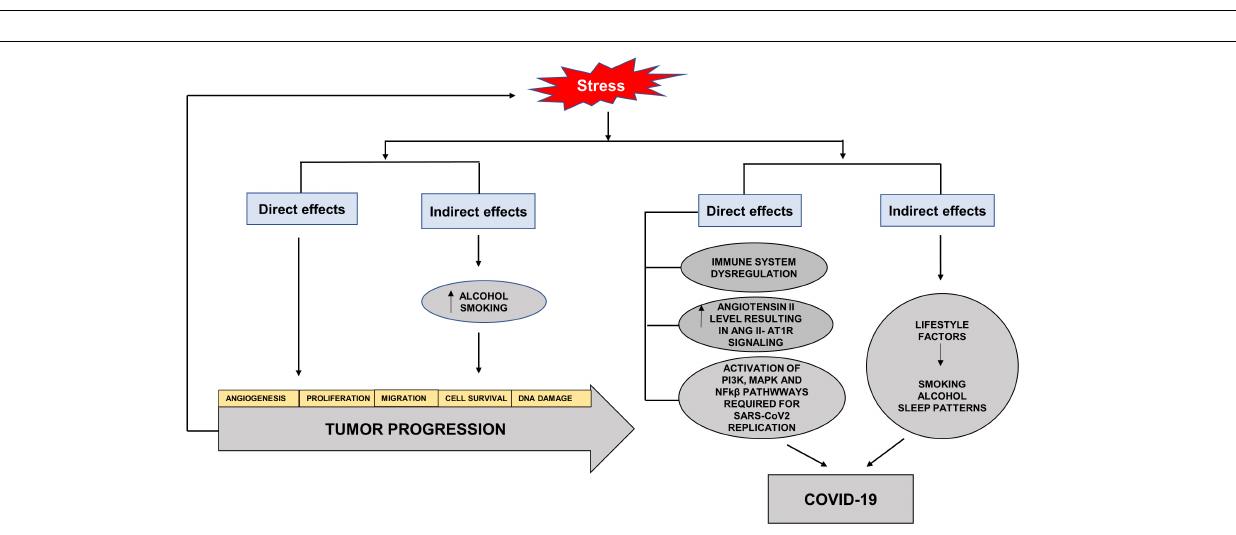
FIGURE 5 | The interplay between SARS CoV-2, cancer progression and stress via the Renin Angiotensin System (RAS). Hijacking of ACE2 receptor by SARS-CoV2 may compromise the protective arm of the Renin Angiotensin System (RAS), by creating a deficiency of ACE2. As a result, there is an increased level of Angiotensin II, since it is not cleaved by ACE2 to Angiotensin 1–7 (black cross). This causes an increase in the pro-tumorigenic and anxiogenic- Angiotensin II- AT1R signaling, which increases the stress hormones and activates the oncogenic pathways. These pathways not only progress the tumor but are also used for replication of SARS-CoV2. Again, due to the deficient ACE2, the axis- ACE2/Angiotensin 1–7/MasR cannot counteract the effects of ANGII-AT1R signaling and unable to block the oncogenic pathways (Green cross) as well as the increased levels of stress hormones (blue cross) and (red cross).